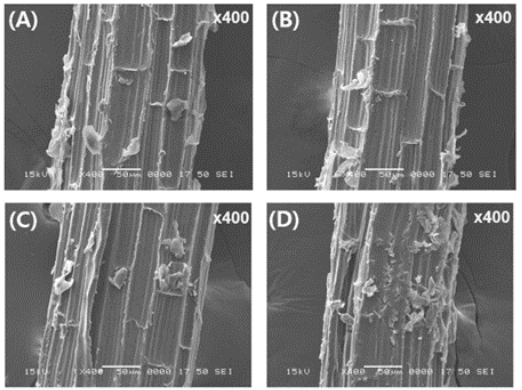
Figure 4. SEM images (×400) of the surfaces of henequen fibers heat treated for different times ( A : 0 min, B : 2 min, C : 5 min, D : 10 min).